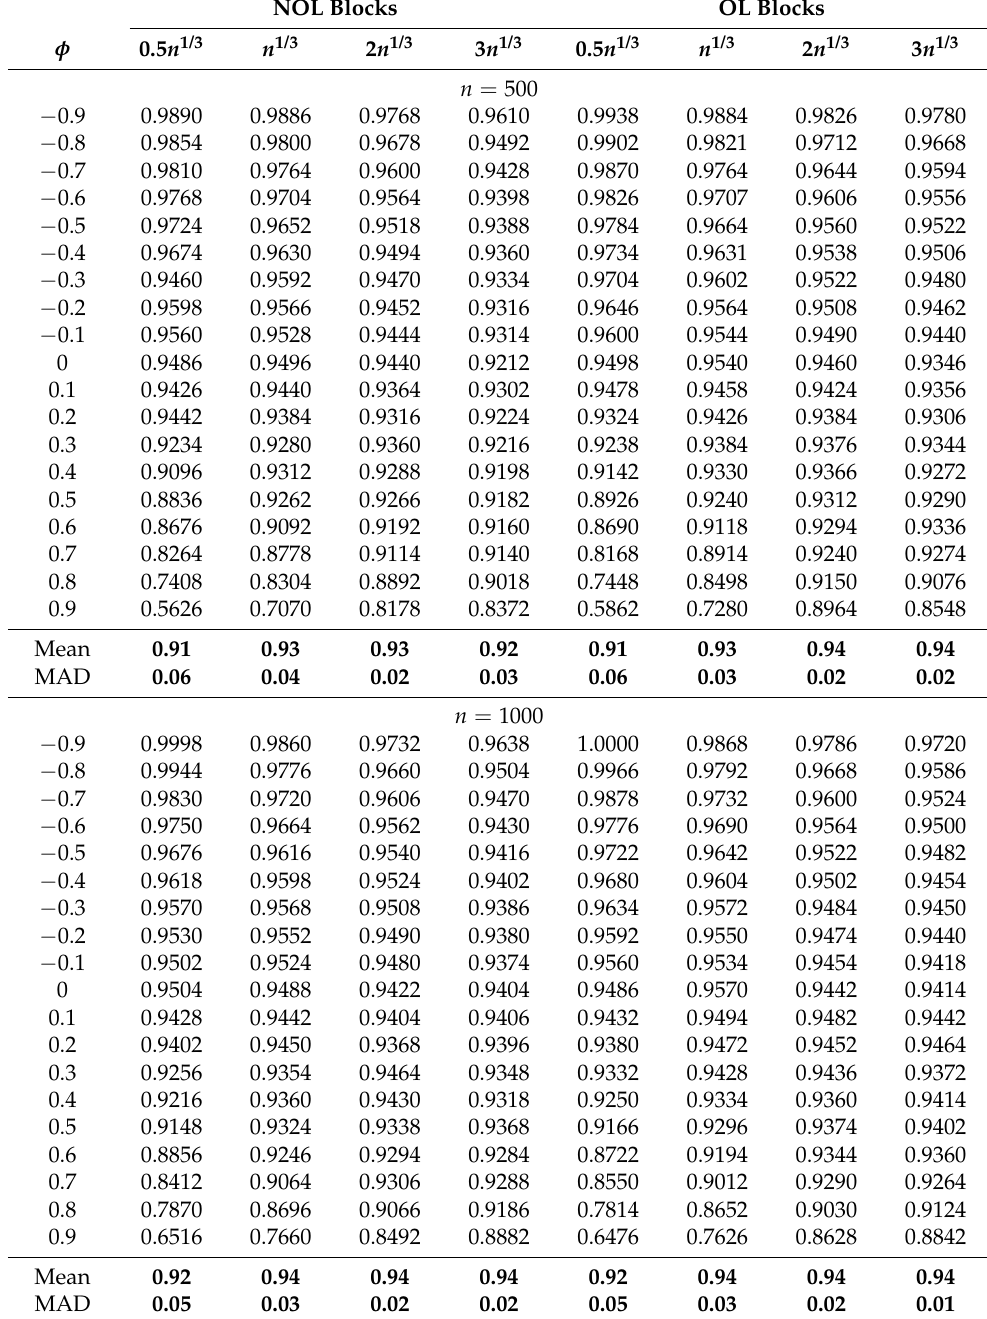
Table 2. Coverage probabilities for 95% BEL CIs for the mean of X t = φ X t − 1 + (cid:101) t ( (cid:101) t i.i.d. standard normal), with n = 500,1000 for NOL and OL blocks of size b = Cn 1/3 using 5000 simulations. Means and mean average deviations (from 0.95) of coverage probabilities are indicated in